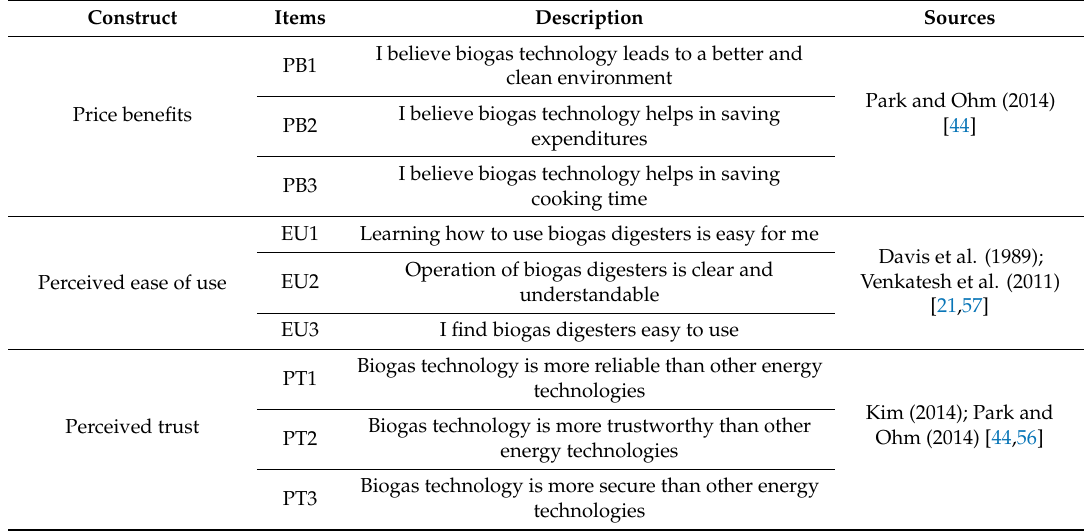
Table A1. Items and source of